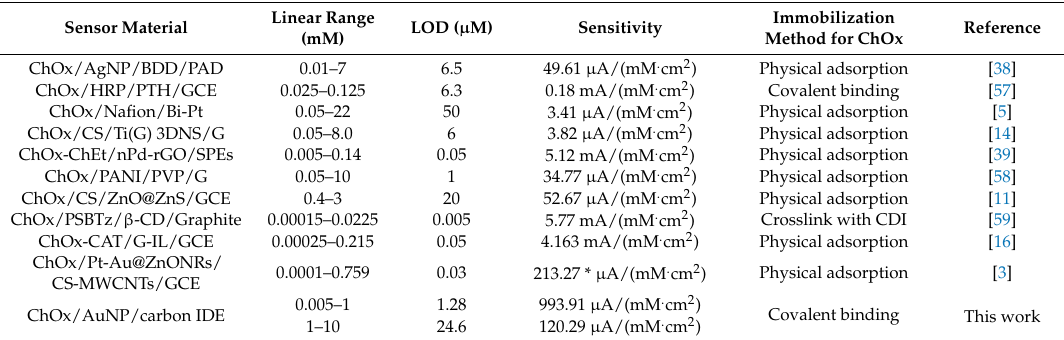
Table 2. Comparison of sensing performances of the presented AuNP/carbon IDE-based cholesterol biosensor with those of various enzymatic